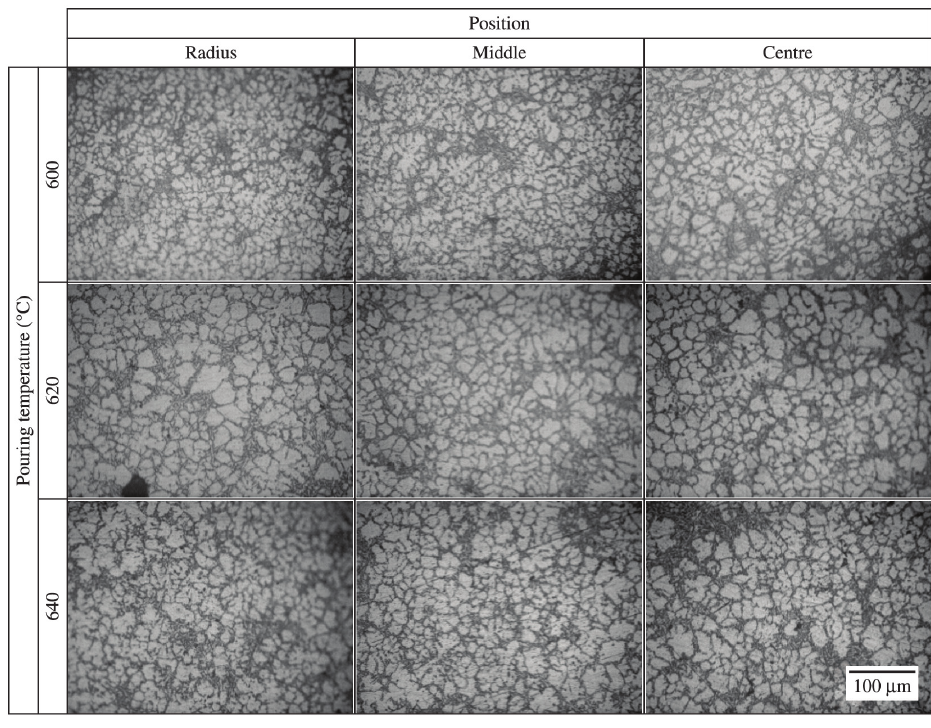
Figure 8. Microstructures of CS cast ingot with water-cooling.